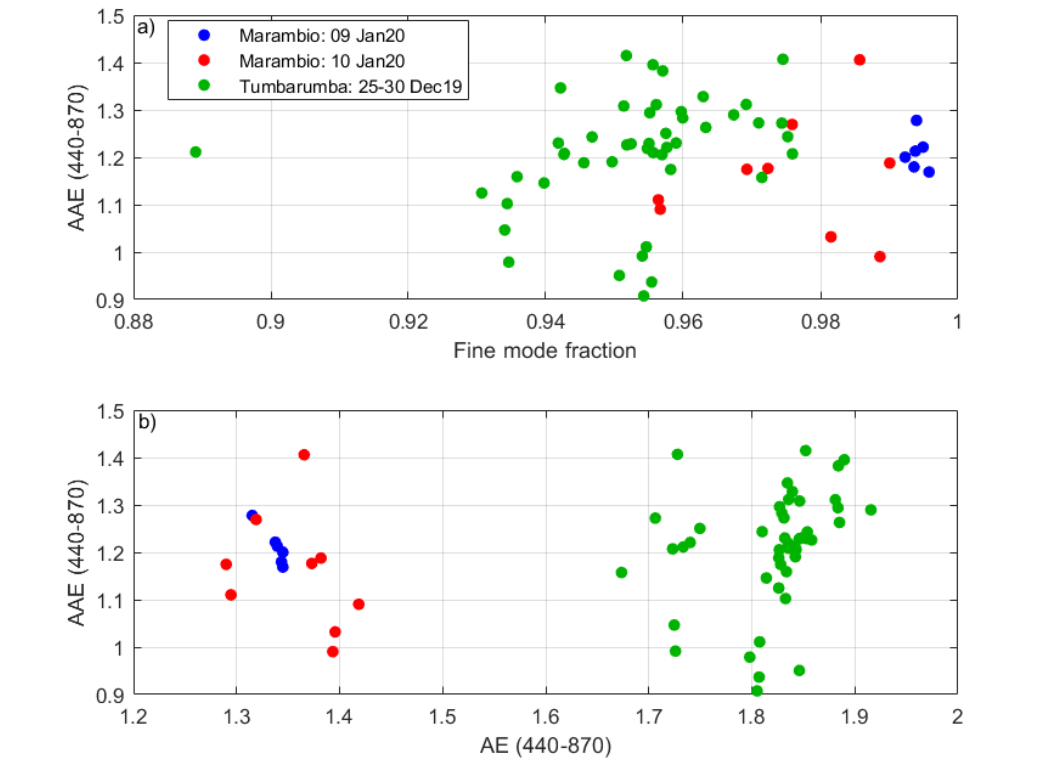
Figure 9. Absorption Ångström exponent (AAE) as a function of: ( a ) Fine Mode Fraction of the AOD (500 nm); and ( b ) Extinction Ångström exponent (AE) derived in the range 440–0870 nm. Data points are inversion data (almucantar and hybrid sky scans) for Marambio, Antarctica, on 9th and 10th January 2020, and Tumbarumba, Australia, for the period 25–30 December